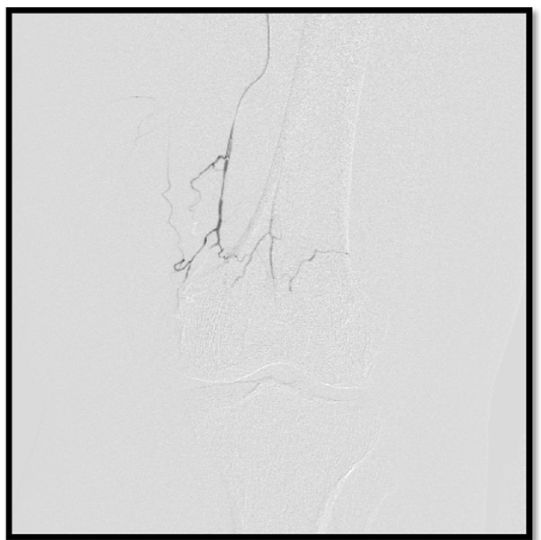
Fig. 3 Angiography post-embolization revealed the absence of the inflammatory blush. The parent genicular artery remains